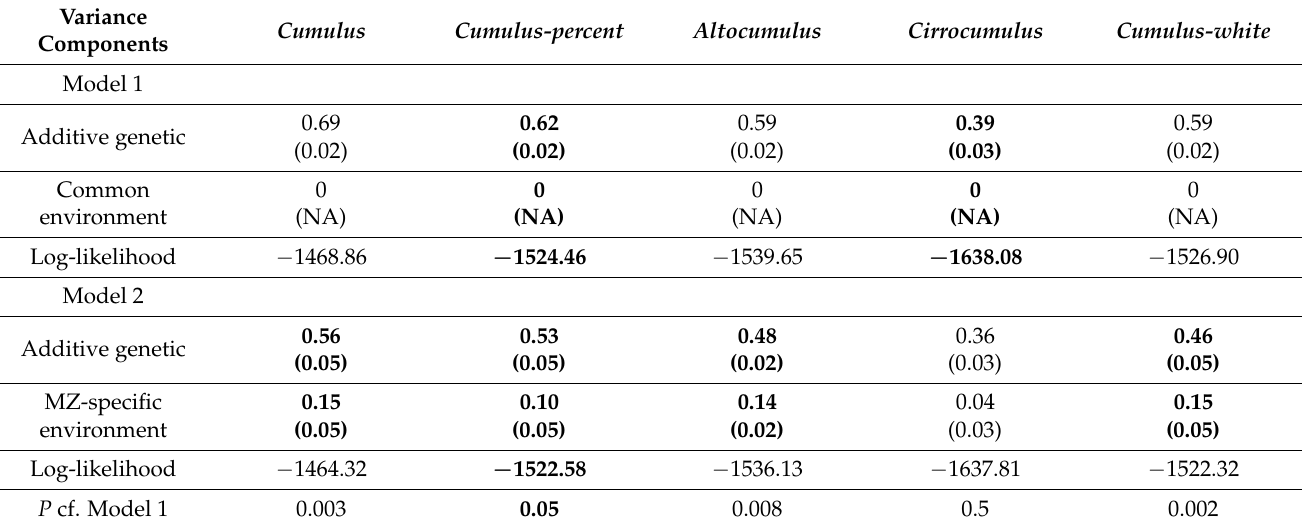
Table 3. Variance components for mammogram risk scores (standard errors in parentheses) for ACE (Model 1) and AE + CMZ (Model 3) with p -values for designated comparisons of model fits based on